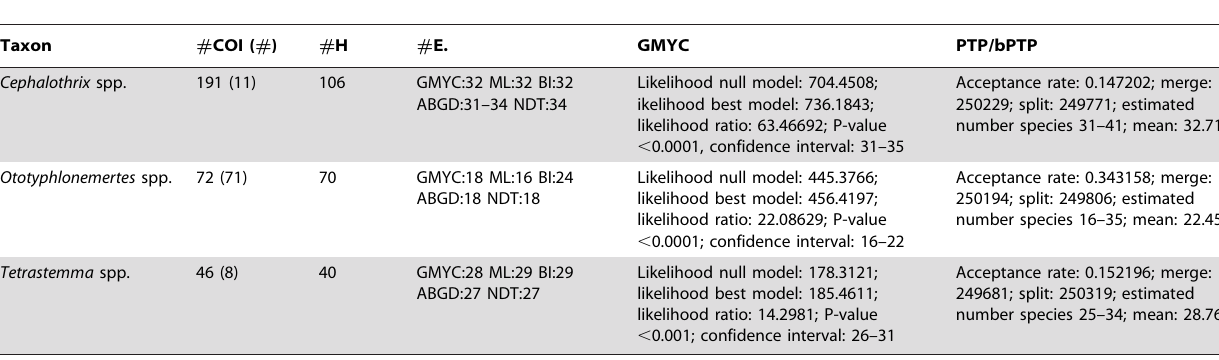
Number of total COI sequences used ( # COI), number of sequences obtained by this work ( # ),number of haplotypes ( # H) are indicated for each genus. Number of entities ( # E.) obtained by each analysis: GMYC model, ML and BI trees attained by PTP/bPTP approach, ABGD, NDT are shown. Moreover, outcomes parameters from GMYC and PTP/bPTP approaches are indicated in the last two columns.